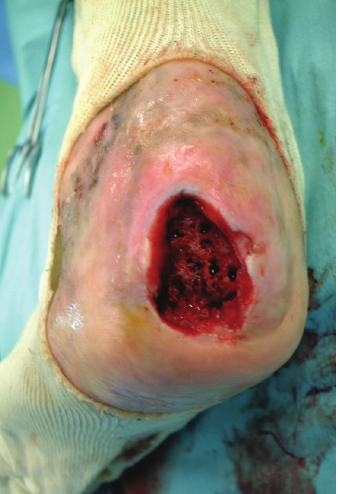
Figure 4: The ulcer received debridements and calcaneal bone was drilled manually by Kirschner